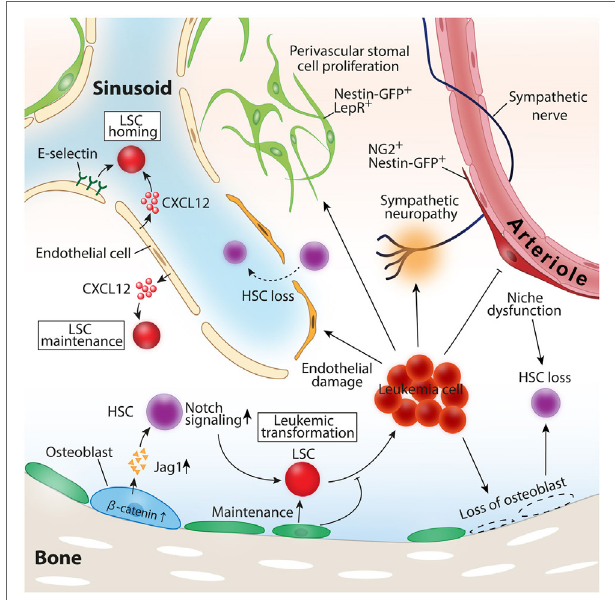
FigURe 2 | Roles of the BM microenvironment in leukemia pathogenesis. Constitutive activation of β -catenin in osteoblast-induced leukemia transformation in mice model. Leukemic cells induce loss of osteoblasts, vascular endothelial cells, and periarteriolar NG2 + stromal cells, leading to healthy hematopoietic stem cell (HSC) loss. CXCL12 and E-selectin expressed by vascular endothelial cells function as inducers of leukemia stem cell (LSC) homing to the bone marrow, and CXCL12 secreted by endothelial cells also contributes to LSC maintenance and the propagation of